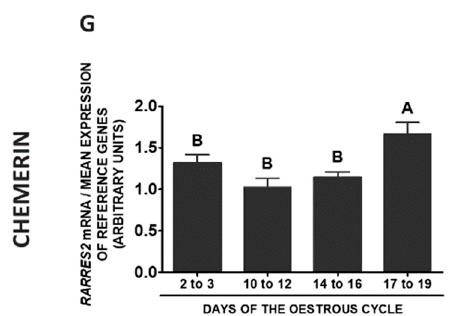
Figure 11. Chemerin system expression in the porcine stalk median eminence (SME) during the oestrous cycle. Gene and protein expression of chemokine-like receptor 1 (CMKLR1; A and B ), G protein-coupled receptor 1 (GPR1; C and D ) and C-C motif chemokine receptor-like 2 (CCRL2; E and F ), as well as chemerin ( RARRES2 ) mRNA content ( G ) in the porcine SME on days: 2 to 3, 10 to 12, 14 to 16 and 17 to 19 of the oestrous cycle. Gene expression was determined by qPCR. Protein expression was determined by Western blotting; upper panels: representative immunoblots; lower panels: densitometric analysis of CMKLR1/GPR1/CCRL2 proteins relative to actin protein. Representative actin blots are identical for all chemerin receptors though proteins have been analysed on different gels. Results are presented as means ± SEM ( n = 5). Bars with different superscripts differ (one-way ANOVA at p < 0.05 followed by Tuckey post-hoc test at p < 0.05).